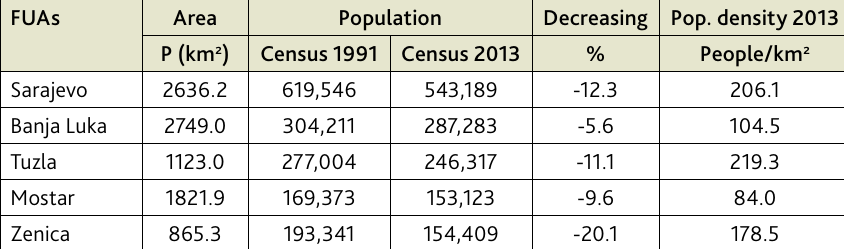
Table 1. Area, population, and population density of FUAs